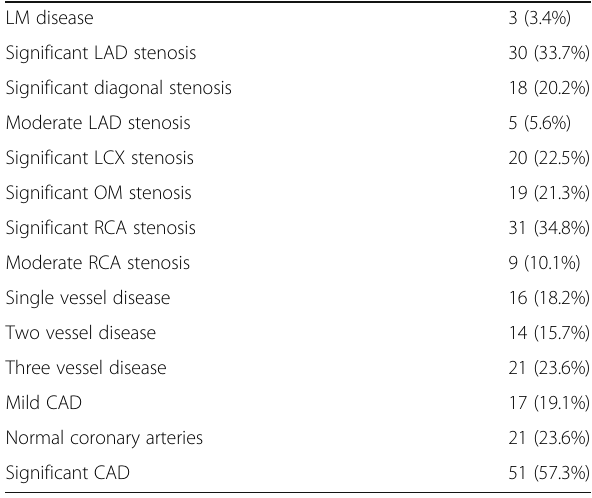
Table 2 Coronary angiography results